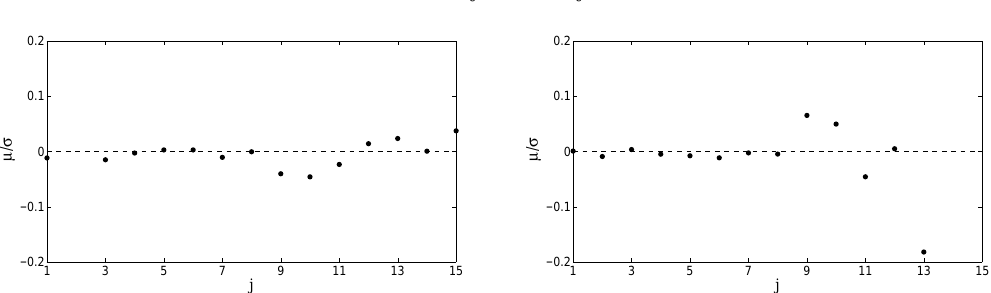
Figure 11. Halloween super storm, 28 October–1 November 2003: SMT applied to the EMD reconstruction of the ground observations for the H (left panel) and D (right panel) components. The x axis is order in terms of the last mode involved in the partial sums (see Eq. 8).